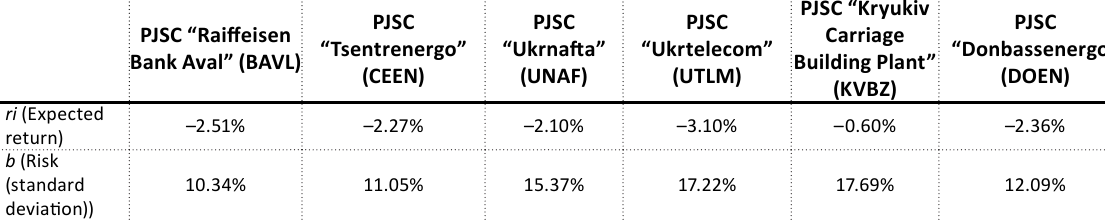
Table 4. Mathematical expectation of return and risk for shares of ordinary companies